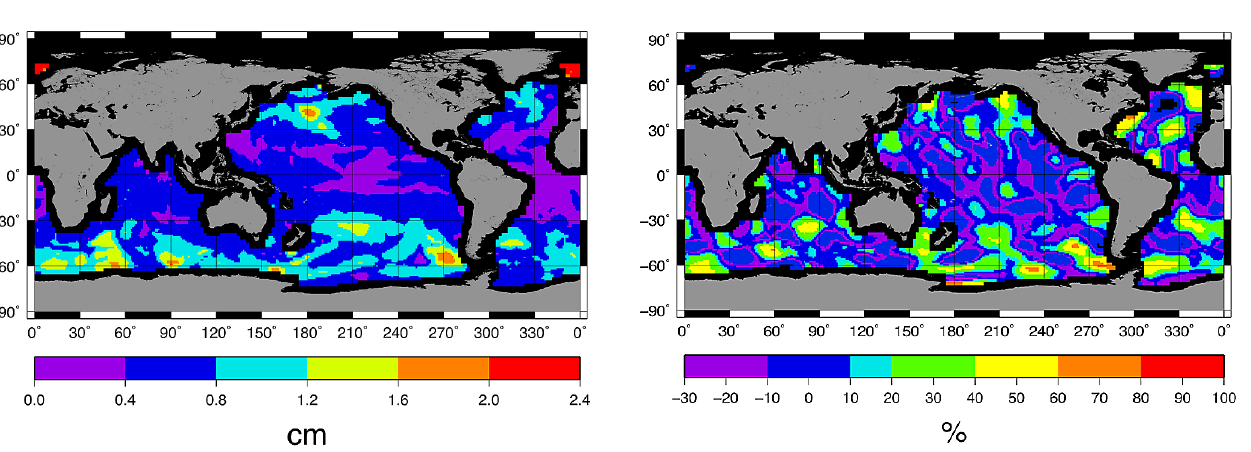
Fig. 10. Estimated standard error in mapped OBP based on Eq. (1) for EOFR filtered CSR RL05 data.